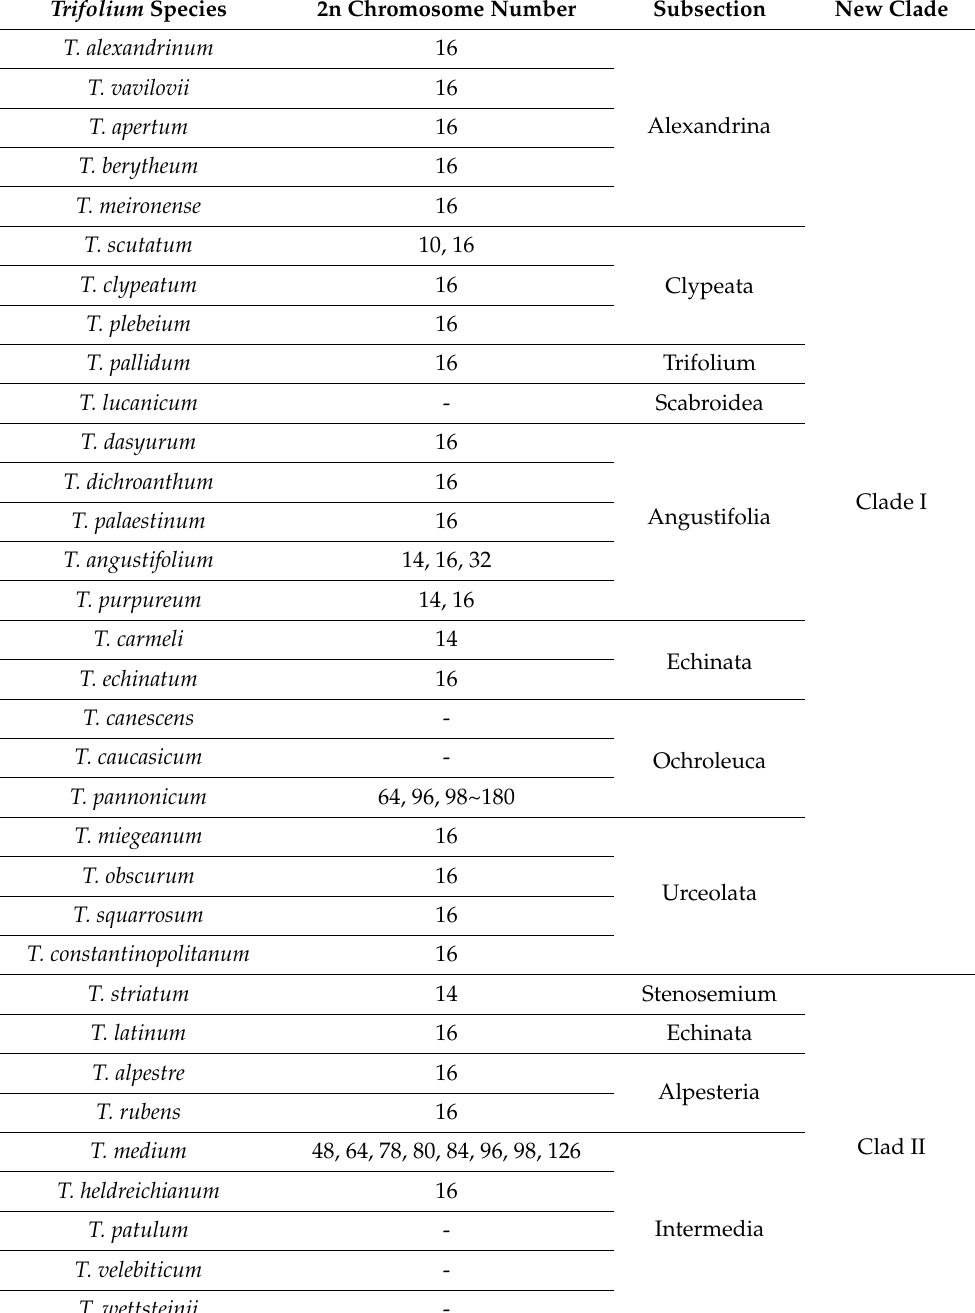
Table 1. Section Trifolium species chromosome numbers and proposed sub-sectional delimitation as proposed by Zohary and Heller [14] and the corresponding classification as three clades in the current study. The listed chromosome numbers searched in the Chromosome Counts Database: http://ccdb.tau.ac.il/Angiosperms/Leguminosae/Trifolium/ and the Missouri Botanical Garden (accessed on 15 June 2021). http://legacy.tropicos.org/Name/40018244?projectid=9 (accessed on 15 June 2021). The 2n cromosomes counts for the following five species were taken from the refrence for each species as follows: T. apertum [42] T. dasyurum [43], T. dichroanthum [14], T. carmeli [44], T. trichocephalum [14], T. haussknechtii